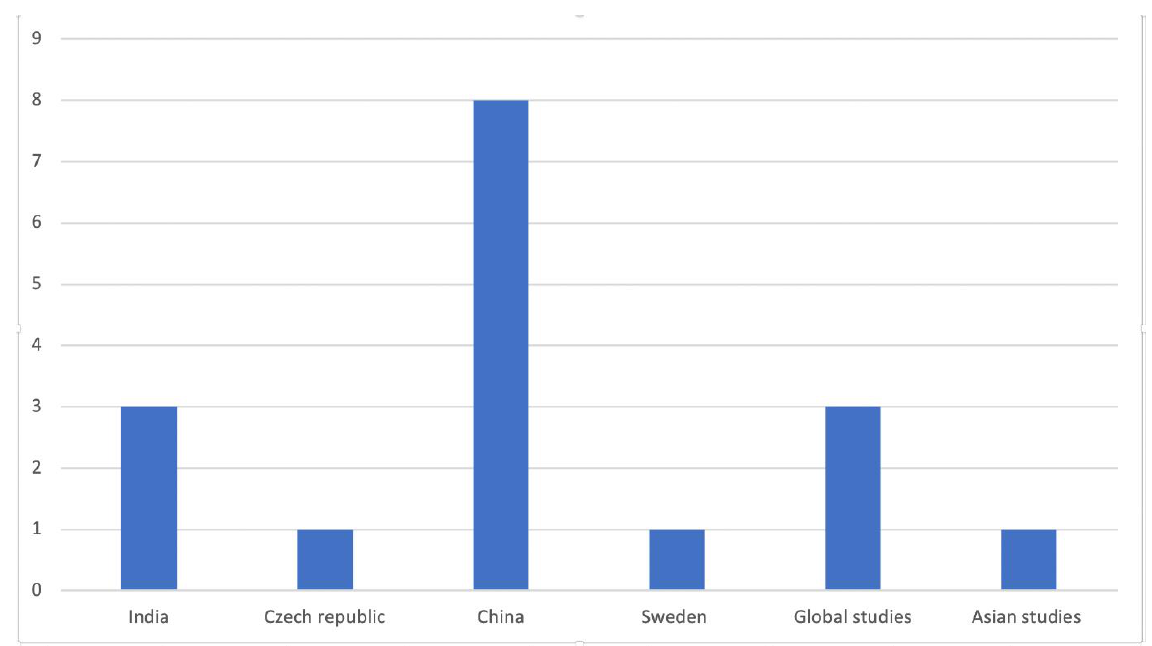
Figure 3. Number of publications that were not included in the meta-analysis based on the area/country.